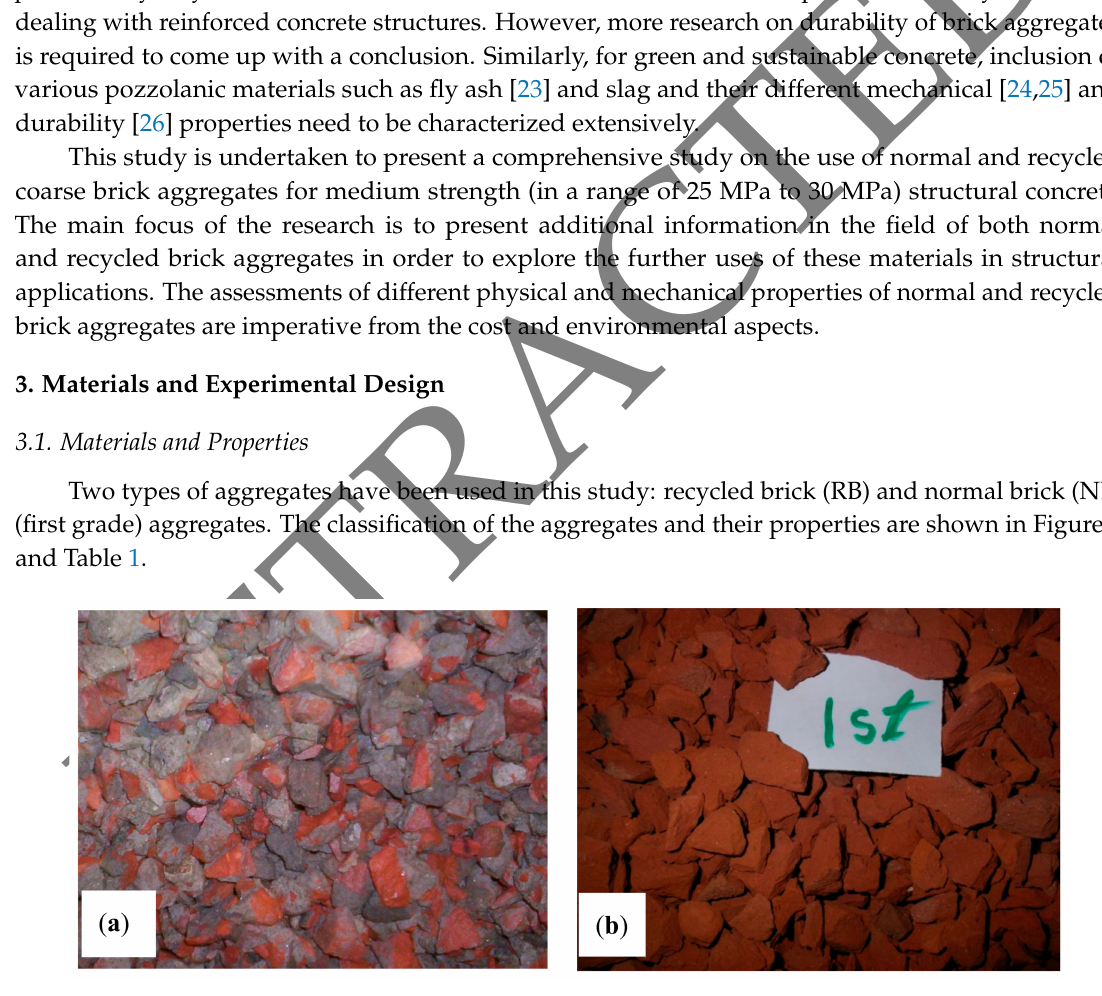
Figure 1. Aggregates for concrete production ( a ) recycled brick aggregate from demolished concrete structure and ( b ) normal brick aggregate (1st